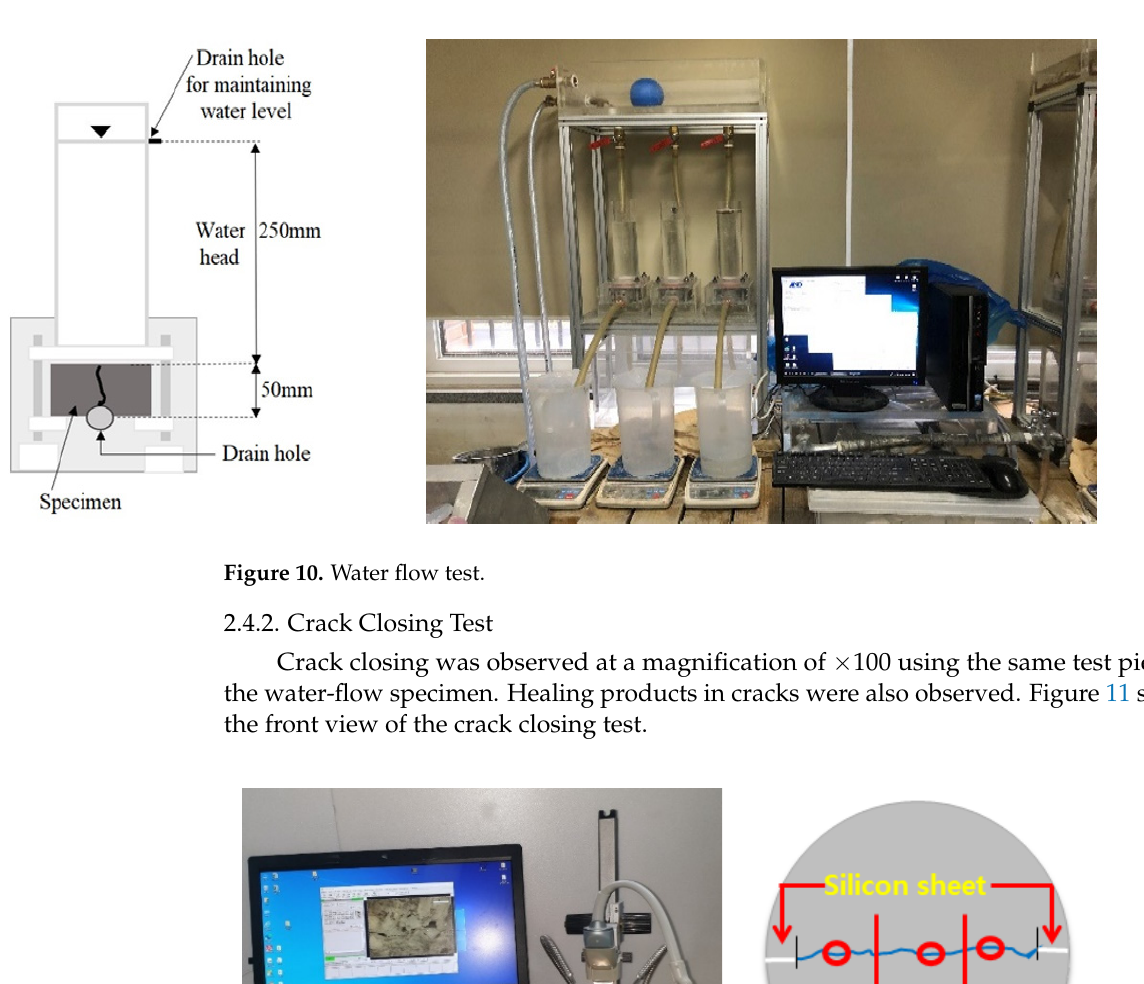
Figure 9. Crack induction and control process: ( a ) crack induction; ( b ) crack control.